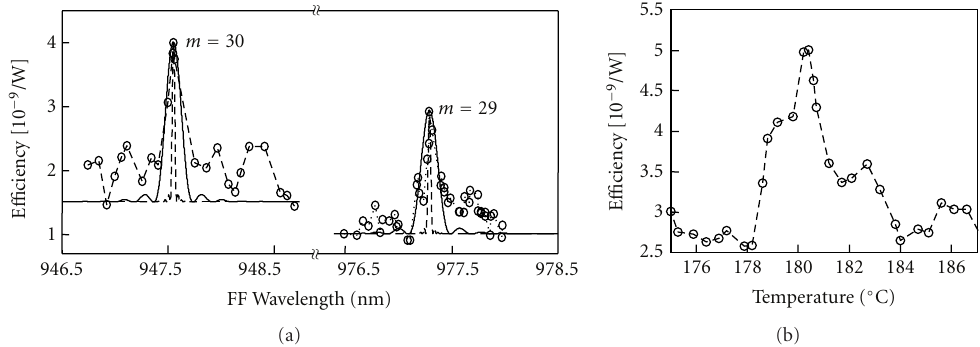
Figure 7: (a) Normalized BSHG conversion e ffi ciency versus FF wavelength for the 29th and 30th QPM orders; (b) normalized conversion e ffi ciency for the 30th BSHG order versus